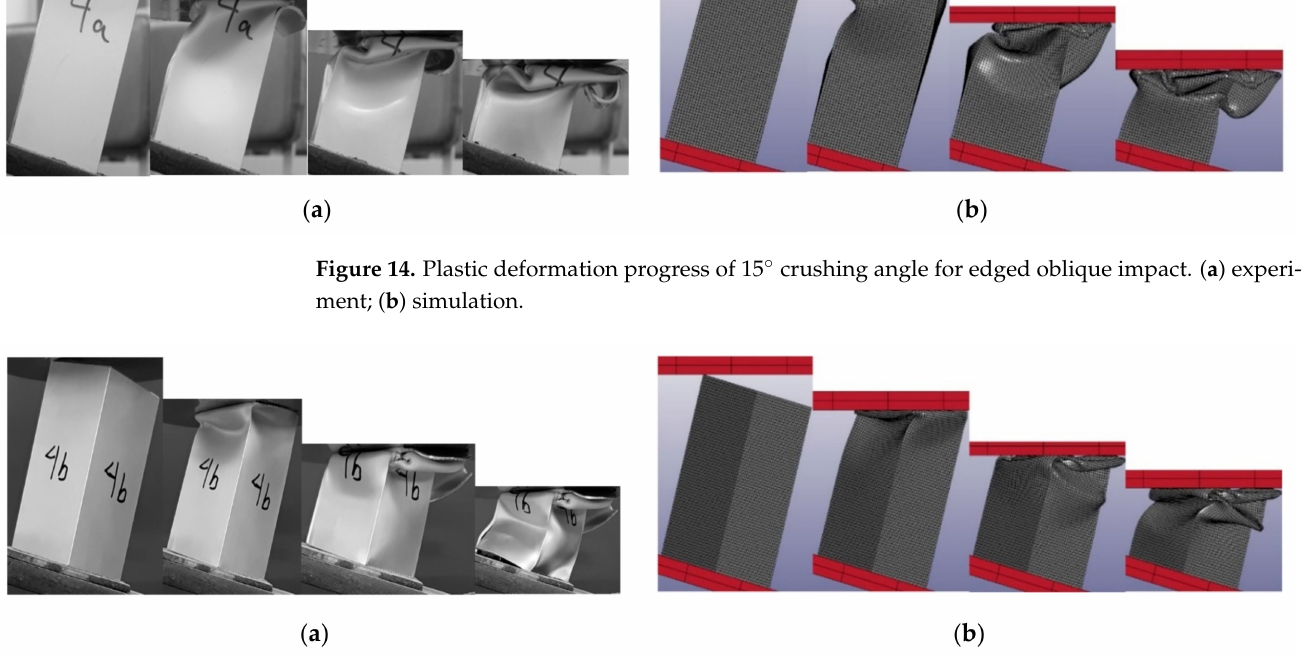
Figure 15. Plastic deformation progress of 15 ◦ crushing angle for cornered oblique impact. ( a ) experiment; ( b )